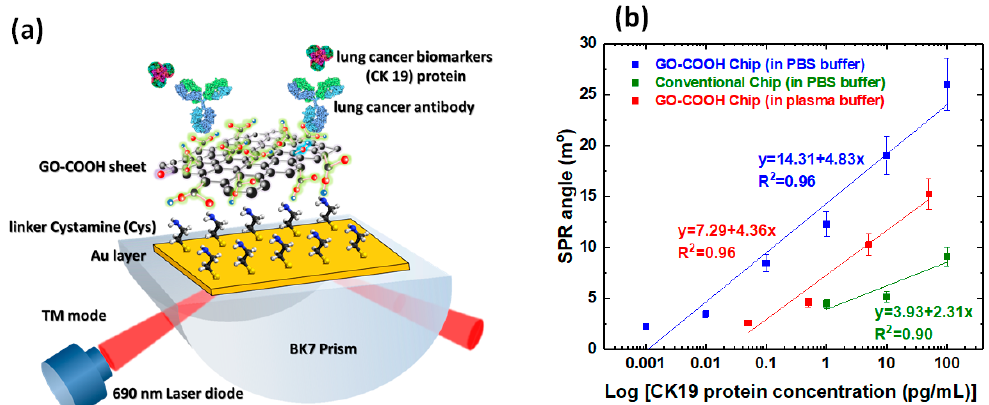
Figure 8. ( a ) Carboxyl-functionalized graphene oxide (GO)-based SPR structure as immunosensor to detect CK19. ( b ) Response of SPR biosensor at different CK19 concentrations and their linear ranges (adapted with permission from Refer- ence [41], copyright Elsevier).